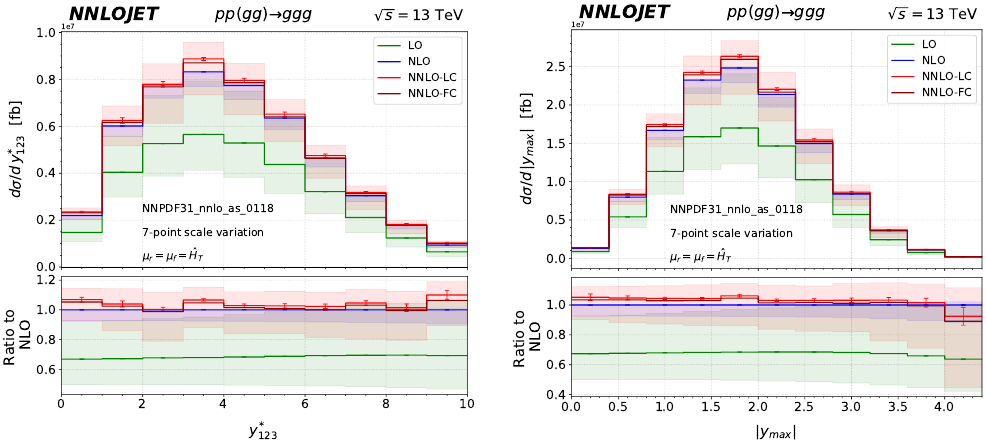
Figure 8 . Gluons-only three-jet production cross section differential in the combined rapidity variables y ? (left) and | y (right) up to NNLO. Definition of NNLO-LC and NNLO-FC as in max | 123 figure